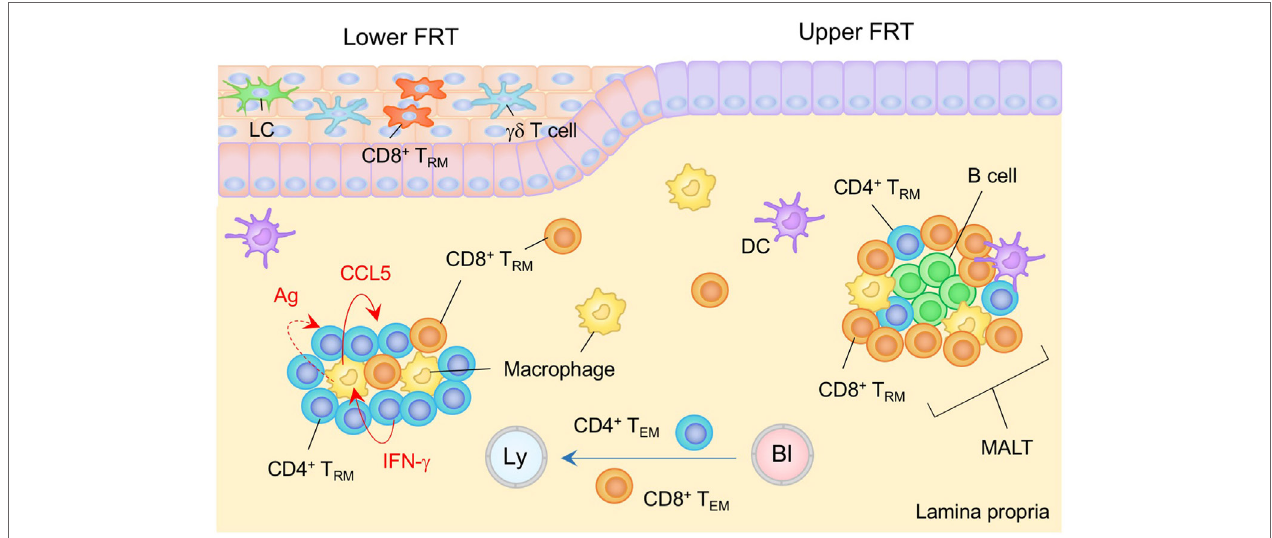
FiGURe 3 | T RM niches in the in the female reproductive tract (FRT). The FRT consist of the upper (endometrium and endocervix) and lower (vagina and ectocervix) reproductive tract. The upper FRT is composed of type I epithelia while the lower FRT is composed of type II epithelia. Mucosa-associated lymphoid tissues (MALT) are found in the lamina propria (LP) of the upper FRT. Both CD4 + and CD8 + T RM cells are involved in the MALT. The size of the MALT is regulated by the phase of the menstrual cycle. In the lower FRT, CD8 + T RM cells present mainly within the epithelial layers. Antigen is not required for the establishment of CD8 + T RM cells in this tissue. CD4 + T RM cells usually form clusters with macrophages in the LP. The structure of the cluster is sustained by a constitutively produced cytokine/chemokine network in which IFN- γ secreted by CD4 + T RM cells drives CCR5 production by macrophages, which attracts and retains CD4 + T RM cells within the cluster. Cognate antigen may be involved in driving CD4 + T cell production of IFN- γ . T EM pass through the LP. Orange and blue cells indicate CD8 + and CD4 + T RM cells, respectively, unless otherwise stated. Red lines indicate the representative niche factors that influence the maintenance of T RM cells. A blue line indicates the migratory route. A dashed line indicates potential impact of niche factor. Abbreviations: Ly, lymph vessel; Bl, blood vessel; Ag, antigen; LC, Langerhans cells; T RM , tissue-resident memory T cells; T EM , effector memory T